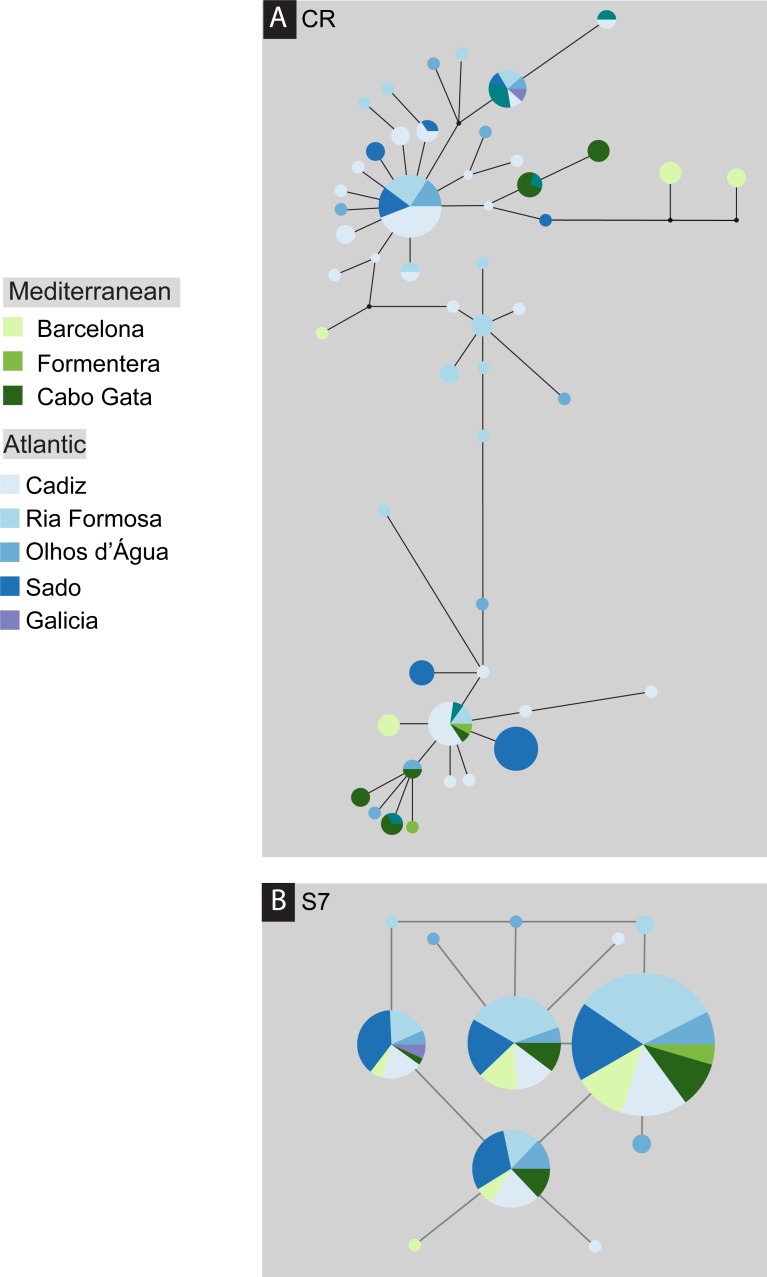
Median-joining post-processed haplotype network for Salaria pavo.Median-joining post-processed control region (A) and S7 (B) haplotype networks for Salaria pavo. The area of the circles is proportional to the frequency of individuals in the sample. Lines are proportional to mutations. Black dots represent median-vectors, or putative haplotypes not sampled or extinct. Colours represent collection location (see key).